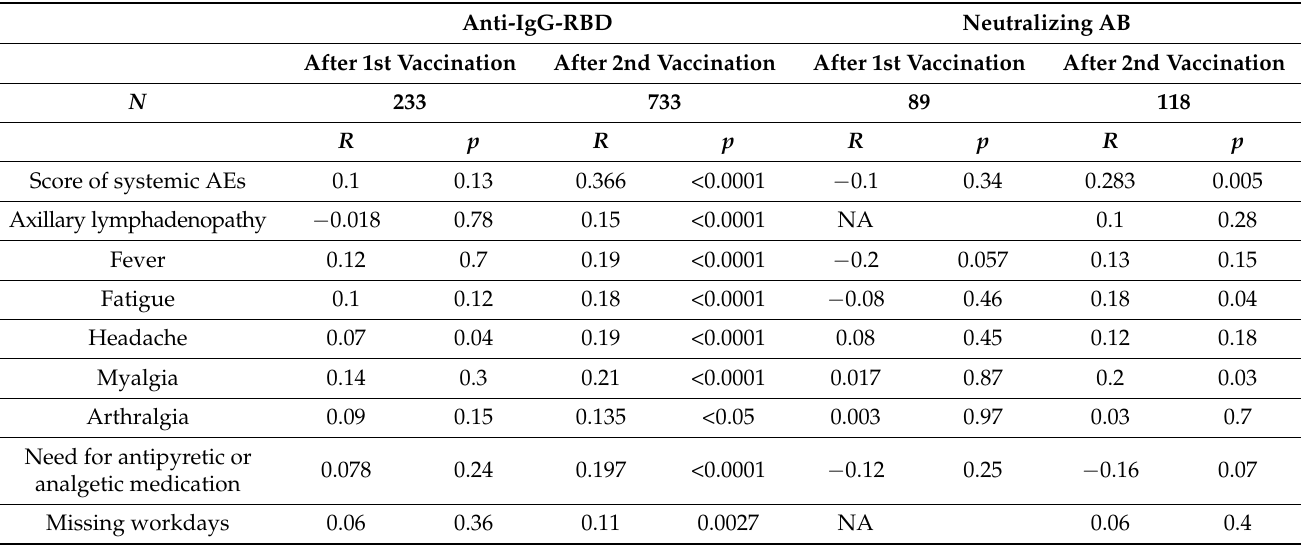
Table 4. Spearman Correlation between adverse events and immunogenicity after the first and the second vaccines adjusted for age, gender, and days after vaccination. Anti-IgG-RBD Neutralizing AB After 1st Vaccination After 2nd Vaccination After 1st Vaccination After 2nd Vaccination 233 733 89 118